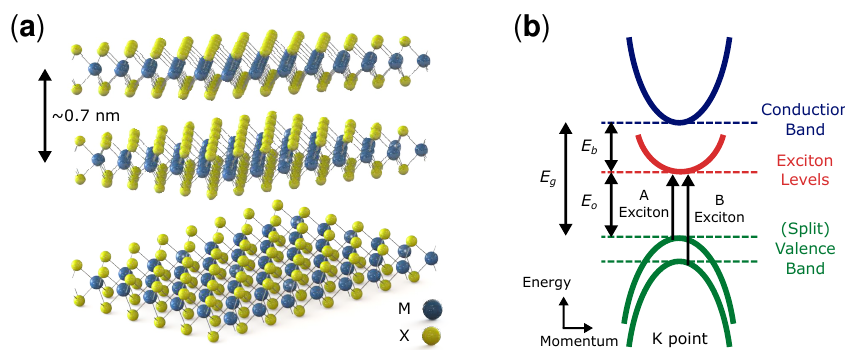
Figure 2. Transition metal dichalcogenide structure: ( a ) visualization of three-layer crystal; ( b ) simplified energy structure at crystal K point for a typical monolayer semiconducting transition metal dichalcogenide (TMD), showing the relationship between the electronic bandgap E , the excitonic binding energy E and the optical bandgap E , including a g b o split valence band from spin-orbit coupling. Excitonic transitions are labelled with letters according to standard nomenclature